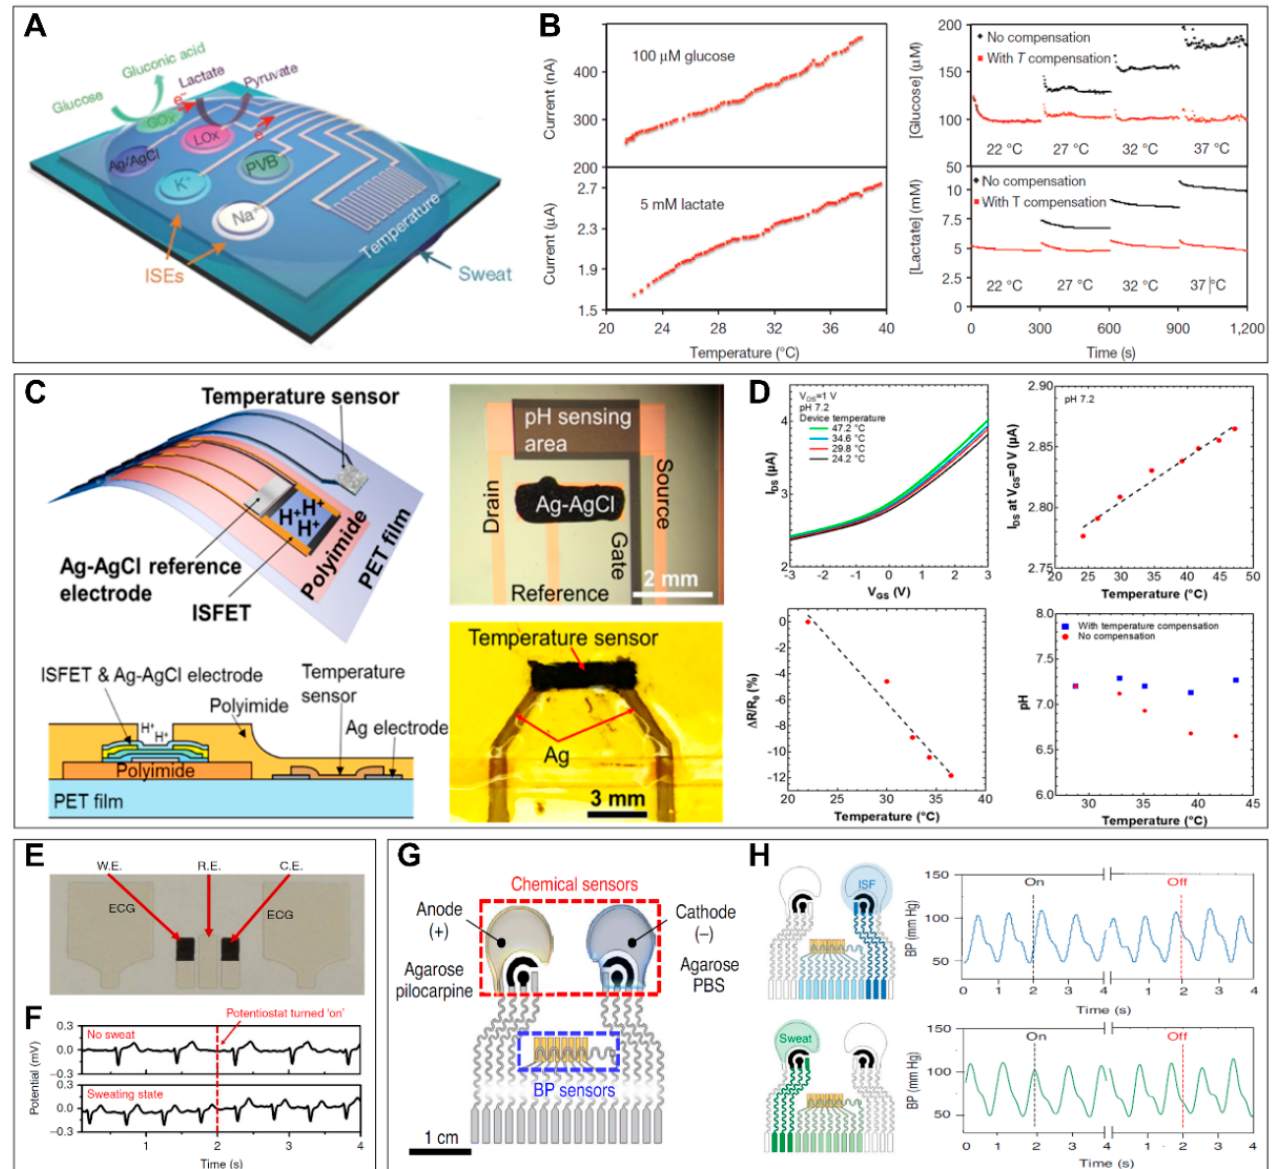
Figure 3. Multiplexed physical–chemical sensor systems. The compensation of one sensor by another sensor is shown. ( A ) Illustration of the hybrid sensor design, consisting of glucose, lactate, and temperature sensors, and the detection site of various biomarkers. ( B ) The graph (left) shows the change in current as temperature increases, on 100 µ M of glucose and 5 mM of lactate. The other graph (right) shows the compensation of the chemical biomarkers according to the different temperature states [89]. ( C ) Description of the hybrid sensor containing temperature and pH sensors; ( D ) shows the calibrated results of pH by utilizing the temperature sensor [90]. ( E ) Actual sensor design of patch-type electrocardiography electrodes and the lactate sensor (comprising three electrodes that are linearly arranged at the center). ( F ) The graph (below the sensor design) shows the effect of applying a potentiostat to the heart rate measurements [91]. ( G ) The sensor’s design consists of chemical sensors for detecting glucose and lactate and physical sensors for detecting blood pressure (BP). ( H ) Graphs illustrating the ability of the sensor to eliminate the crosstalk between the applied voltage, which was used to detect the chemical biomarkers and the applied ultrasound that was used to detect the BP. The upper graph shows glucose–BP detection, and the lower graph shows lactate–BP detection [30].